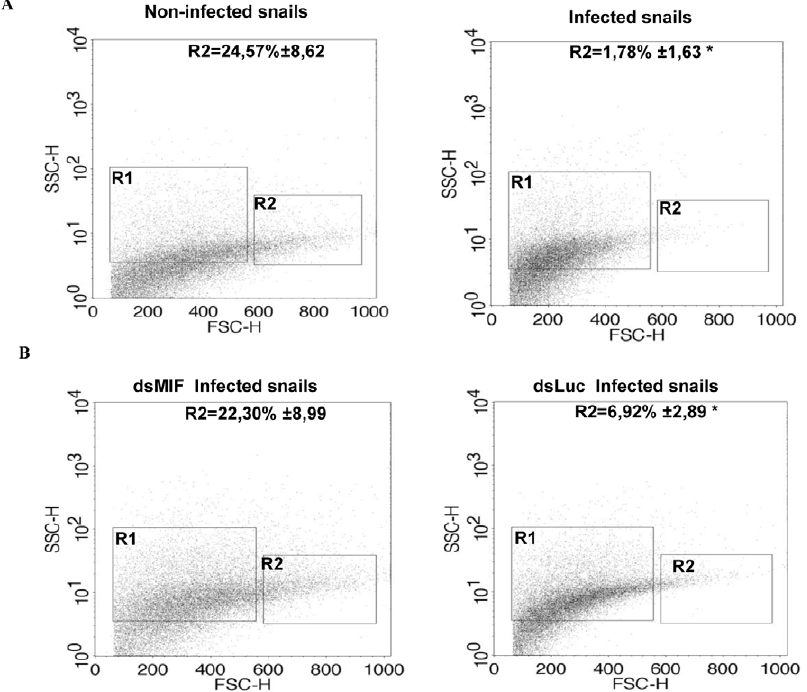
Figure 9. BgMIF is implicated in hemocyte activation in response to parasitic infection invivo . (A) Profile of circulating hemocyte populations in non-infected or infected B. glabrata 24 h after infection with 15 S. mansoni miracidia. Two major hemocyte subpopulations (R1= small and medium and R2= large) can be identified by flow cytometric dot plot distribution based on laser forward scatter (FSC) versus laser side scatter (SSC). Mean percentages of the R2 population + / 2 S.D. in three separate experiments is shown. (B) Effect of S. mansoni infection on the circulating hemocyte populations of dsLuc or dsMIF treated snails. Mean percentages of the R2 population + / 2 S.D. in three separate experiments is shown. *designates values that differ significantly from the R2 population of non infected snails ( p , 0.05).